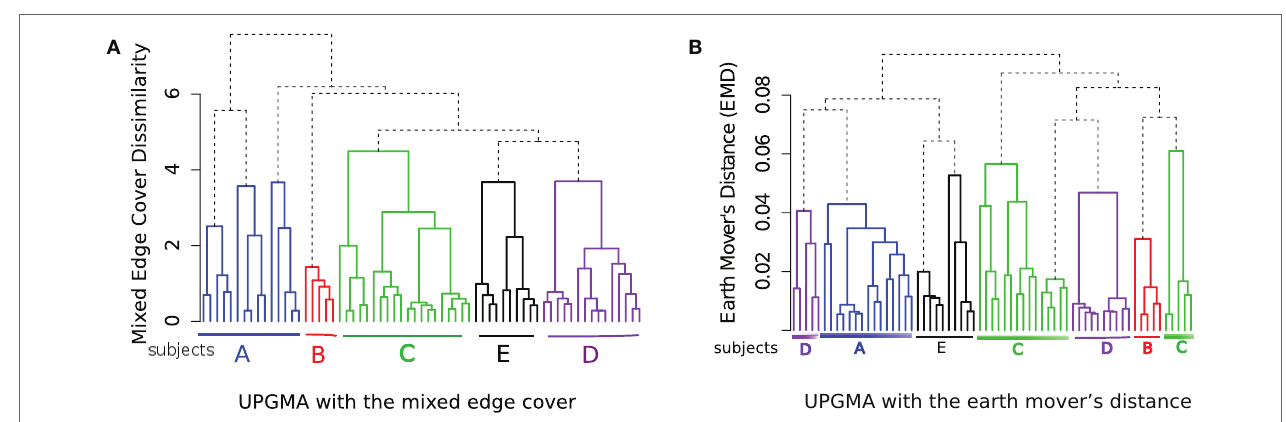
FigUre 10 | hierarchical organization of hD samples using the UPgMa algorithm using (a) the mixed edge cover (with Mahalanobis distance as the distance between clusters) and (B) the earth mover’s distance as the dissimilarity between every pair of samples .